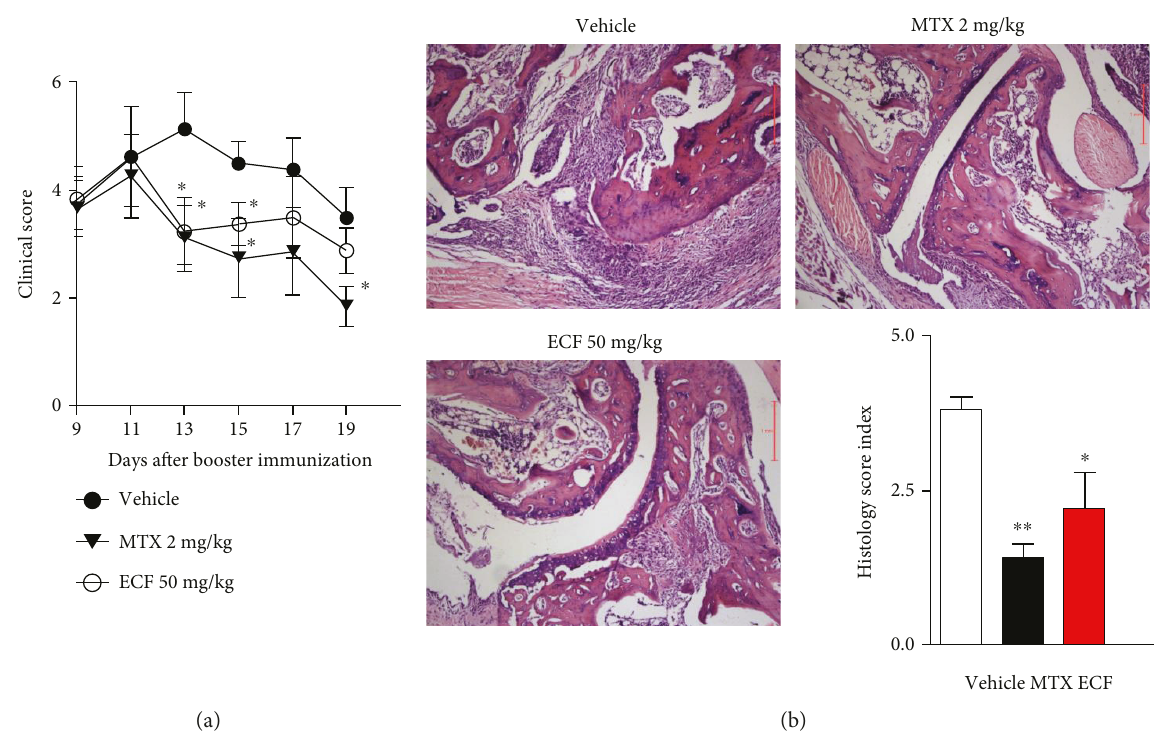
Figure 2: ECF attenuates collagen-induced arthritis in DBA/1 mice. Collagen-induced arthritis in DBA/1 mice was established via immunization twice with bovine collagen II in CFA. Mice were administered o.p. with vehicle, methotrexate (2 mg/kg), or ECF (50 mg/kg) once daily, starting from day 9 for 10 days. The severity of arthritis (a) and pathological changes to the joints (b) were evaluated using a clinical scoring system and H&E staining, respectively. Results presented are mean ± s.e.m., n = 7 . ∗ P < 0 05 , ∗∗ P < 0 01 versus vehicle group. IFN- γ , TNF- α , IL-6, IL-17A, and